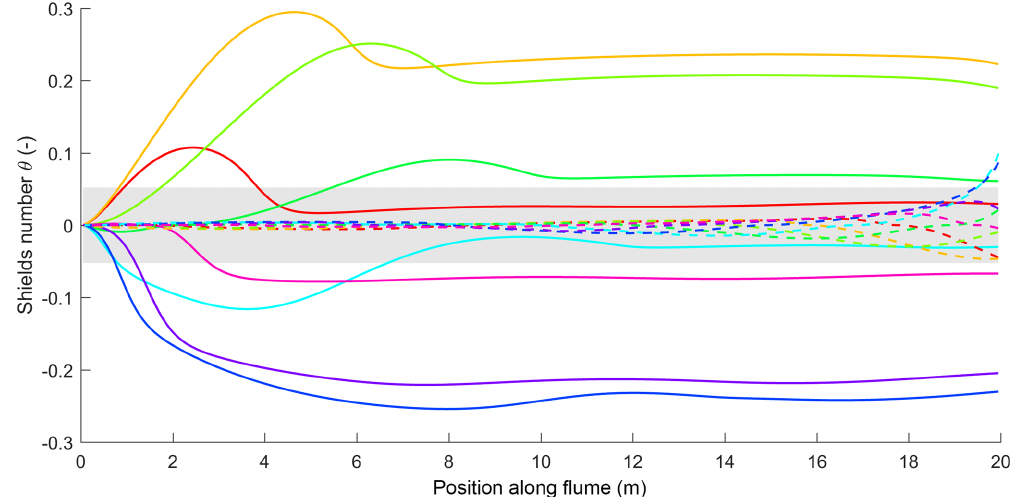
Figure 15. Sediment mobility calculated for tidal flows driven by periodic tilting (drawn lines) and by the Reynolds method with periodic sea surface fluctuation (dashed lines). Legend as in Fig. 9. Grey area indicates immobile